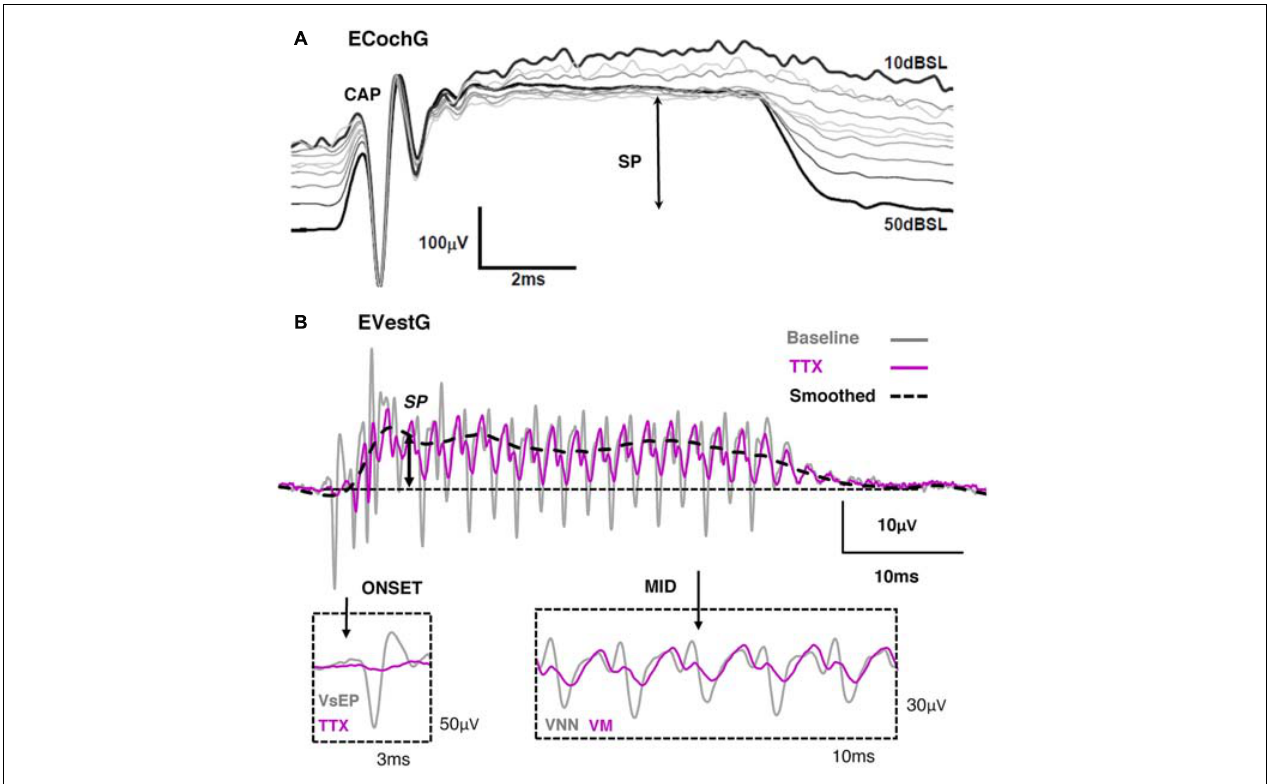
FIGURE 10 | (A) Electrocochleography (ECochG) response recorded from the round window of the guinea pig during an 18 kHz, 10ms tone burst of varying intensity. Reproduced (adapted) from ‘Origins and use of the stochastic and sound-evoked extracellular activity of the auditory nerve’. Pg. 153. Doctoral Thesis. The University of Western Australia. Daniel Brown. 2006. With permission from Copyright owner Daniel Brown. (B) Electrovestibulography (EVestG) response taken from the facial nerve canal of the guinea pig to 507 Hz, 40 ms BCV train burst. Tetrodotoxin (TTX) abolished the onset VsEP (gray) and the mid response VNN (gray), leaving behind the VM and SP. Reproduced (adapted) from Pastras et al. (2021) Copyright Elsevier (Hearing